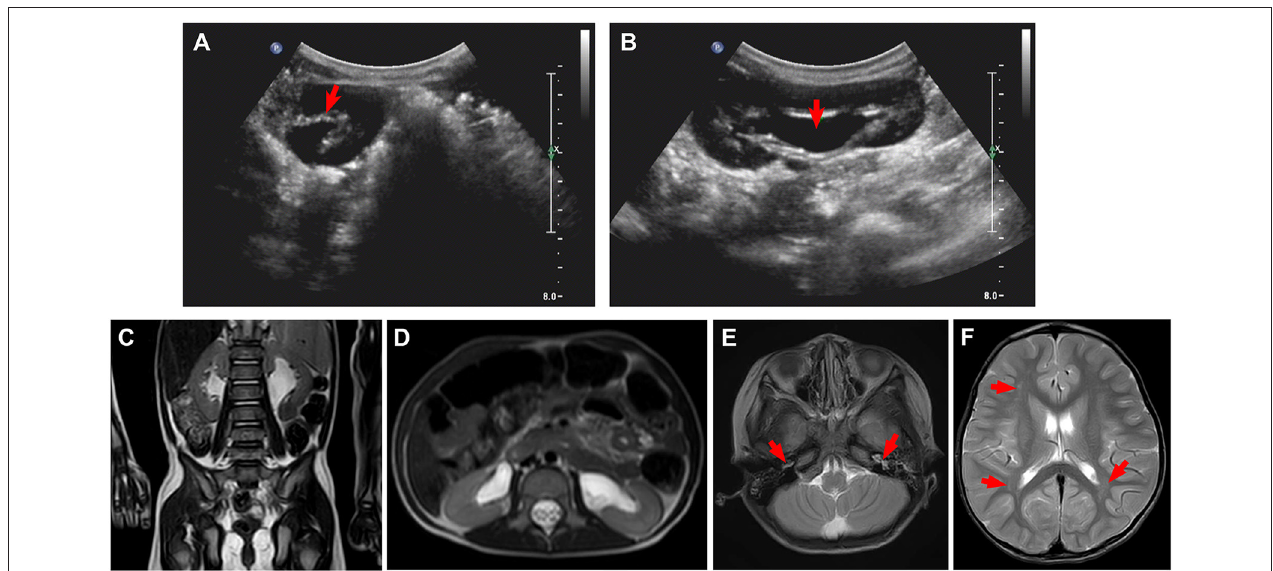
FIGURE 1 | Ultrasound and magnetic resonance imaging (MRI) for kidneys and brain. (A,B) Ultrasound shows small crystals in the sinus of both kidneys, bilateral upper ureteral dilatation, and hydronephrosis. (C,D) MRI confirms bilateral hydronephrosis and ureteral dilatation, in particular, left side. (E,F) Cranial MRI scan shows bilateral mastoiditis ( E , arrows) and abnormal patchy signal intensity in the anterior and posterior horns of the bilateral ventricles ( F , arrows), indicating delayed myelination.